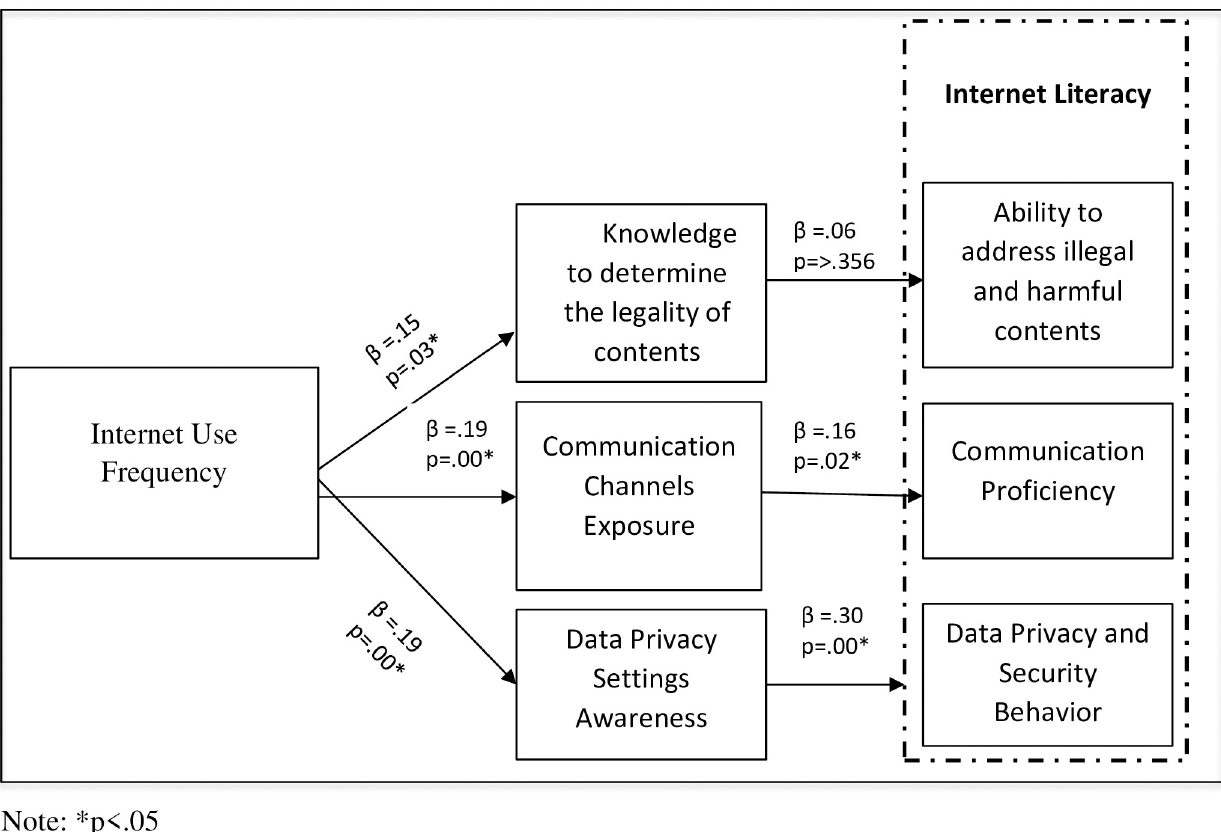
Fig 3. Internet literacy mode.